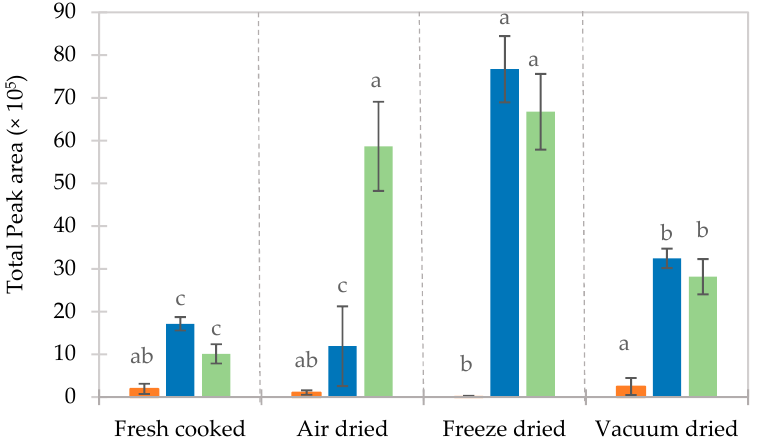
Figure 6. The influence of the processing method on the retention of key volatile compounds: dimethyl sulfide ( ◼ ), 2-ethyl-1-hexanol ( ◼ ) and hexanal ( ◼ ), in rehydrated pre-cooked beans. Parameters not sharing the same letters are significantly different ( p < 0.05).